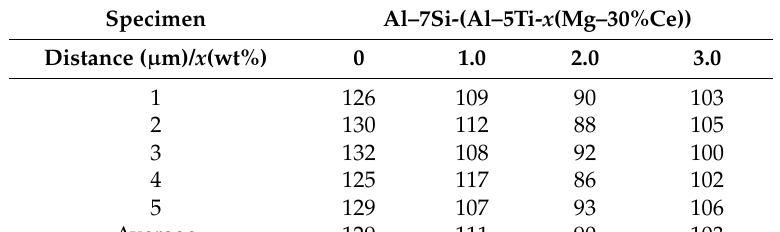
Table 1. The average grain size of specimens.